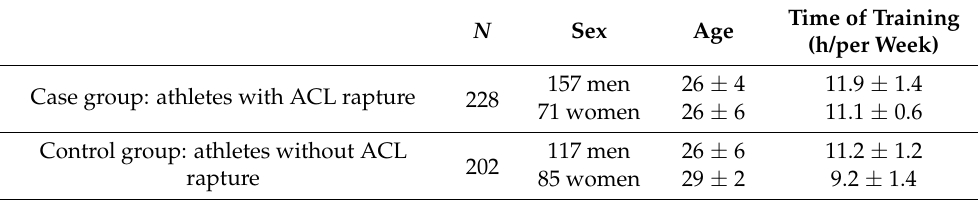
Table 1. Characteristics of the study